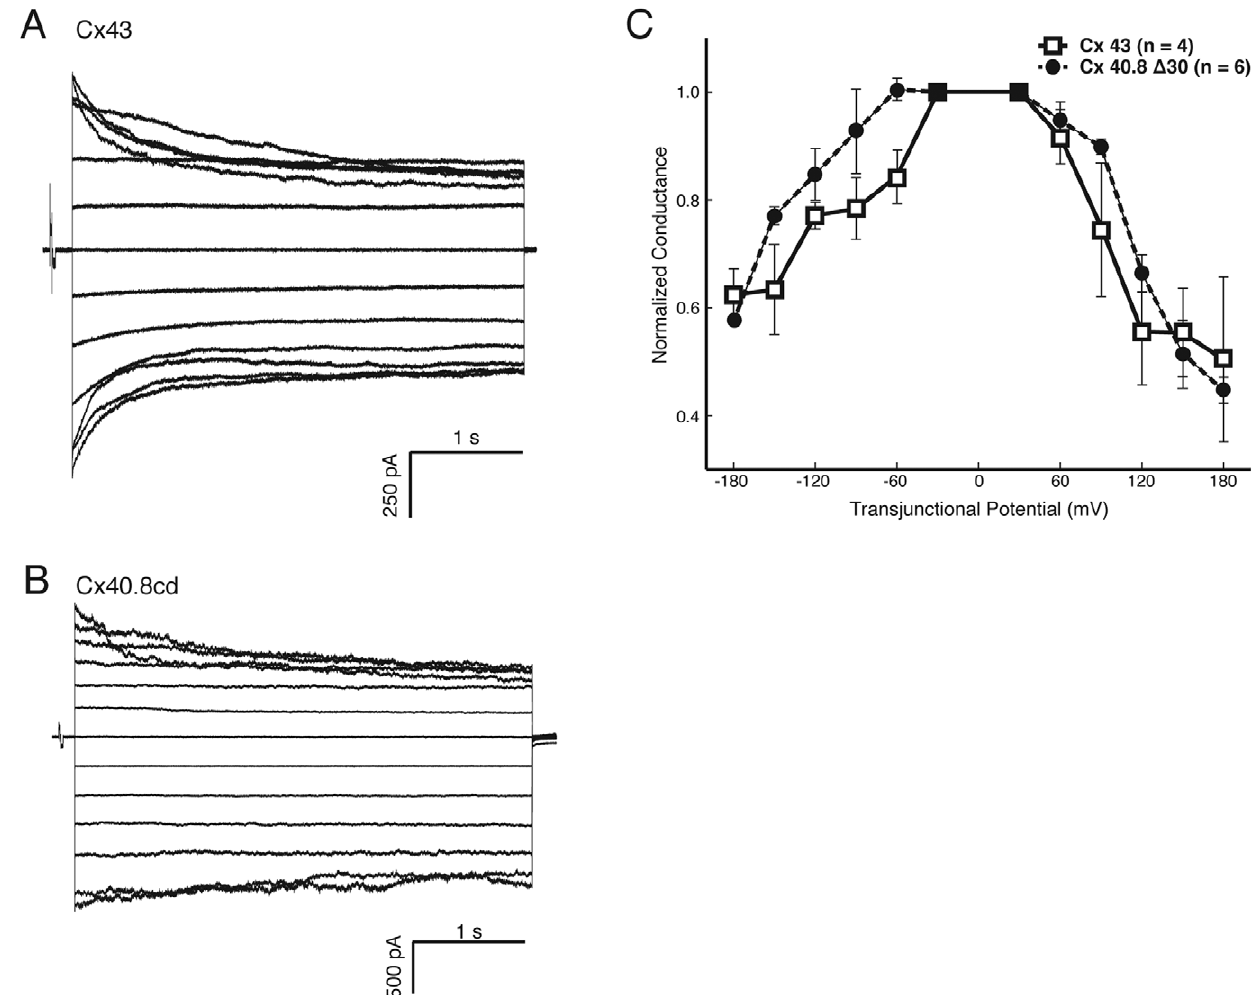
Figure 8. Voltage dependent conductances are similar between Cx43 and Cx40.8-cd in transiently transfected N2a cells. (A) Transjunctional current family from a Cx43 expressing cell pair. V j was varied 6 180 mV in 30 mV steps. (B) Currents from a Cx40.8 expressing pair. (C) Normalized steady state G j measures as a function of V j show similar inactivation properties between the two constructs. Error bars are SEM.